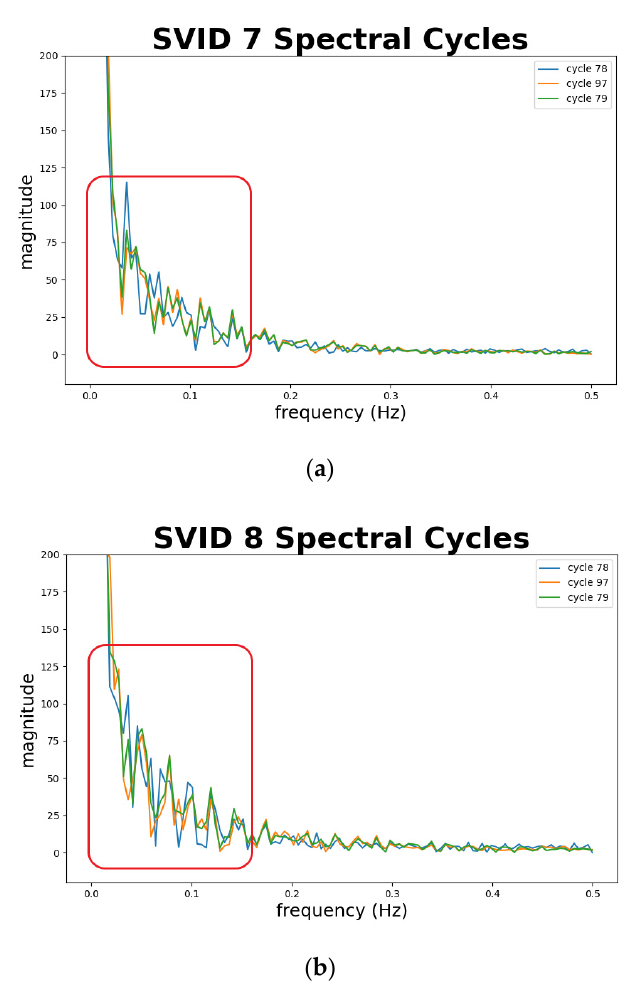
Figure 13. Abnormal sequences comparing to a normal sequence in spectra from two SVIDs: ( a ) 7th SVID; ( b ) 8th SVID.